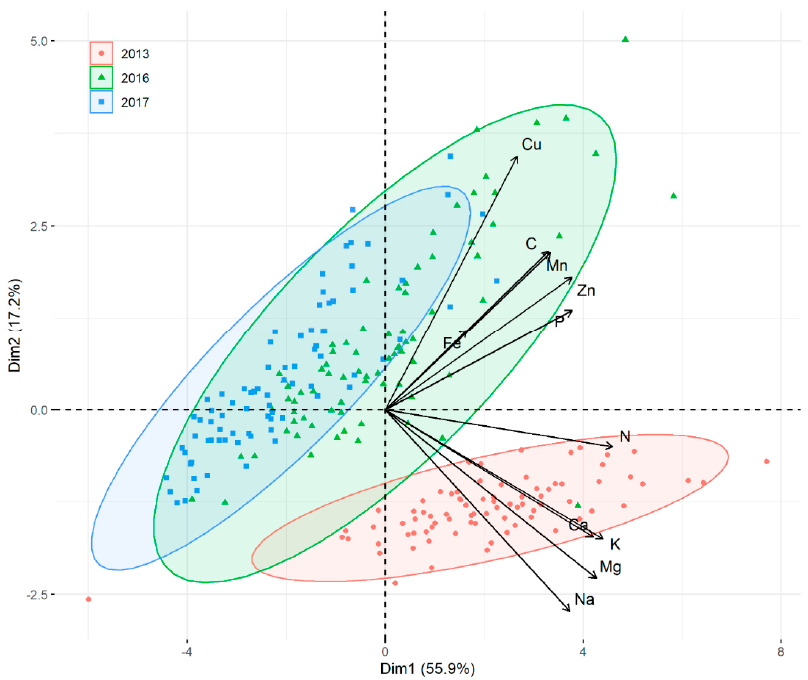
Figure 4. Scores and loadings for PCA performed for the distribution of nutrient contents for the three study years (2013, 2016, and 2017), corresponding to the total element content in the avocado fruit.